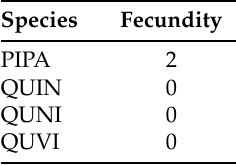
Table A21. Species fecundity parameters.